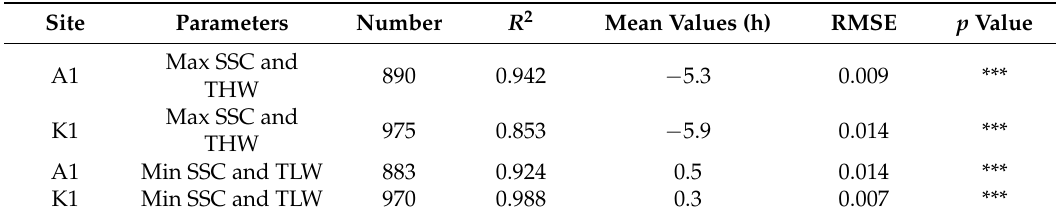
Table 5. Gaussian fit results of the frequency between the time of minimum SSC and THW or